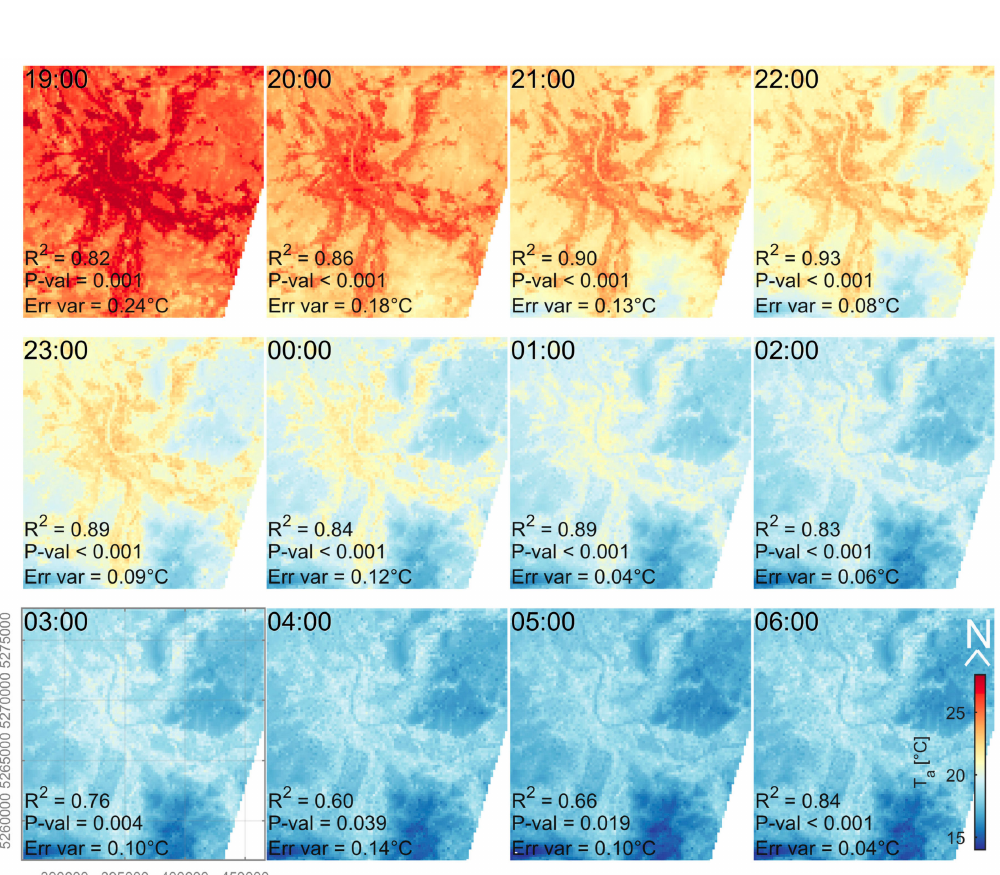
Figure 4. Outputs for the Land Cover model representing the about-roof level temperature for the specific heat wave in August 2016 as an average with 200 m resolution. The coordinate system indicated in the lower left map is UTM-32N and the time is